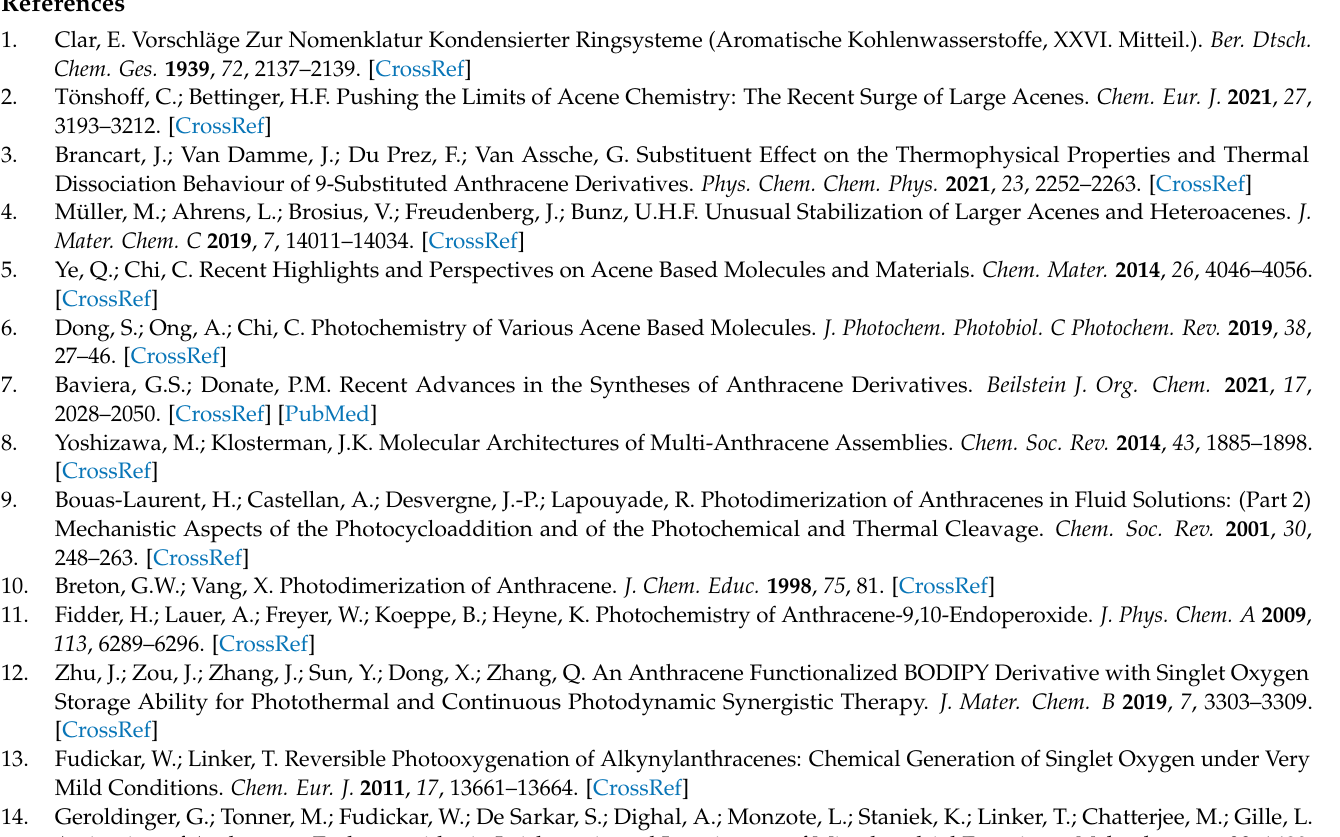
tion, Figure S4: 1 H-NMR spectra of anthraquinone, Figure S5: Photodimerization of anthracenes A and B under inert gas atmosphere, Figure S6: the comparison of photodimerization curves of A and B in separate samples, and in the mixture when fitting was done using the first 6000 s, and the model included the product of oxygenation as well as unidentified products, Figure S7: 1 H-NMR spectra of A and B in separate samples, and in the mixture using benzene as a solvent, Table S1: kinetic constants k XA , k XB and k BO